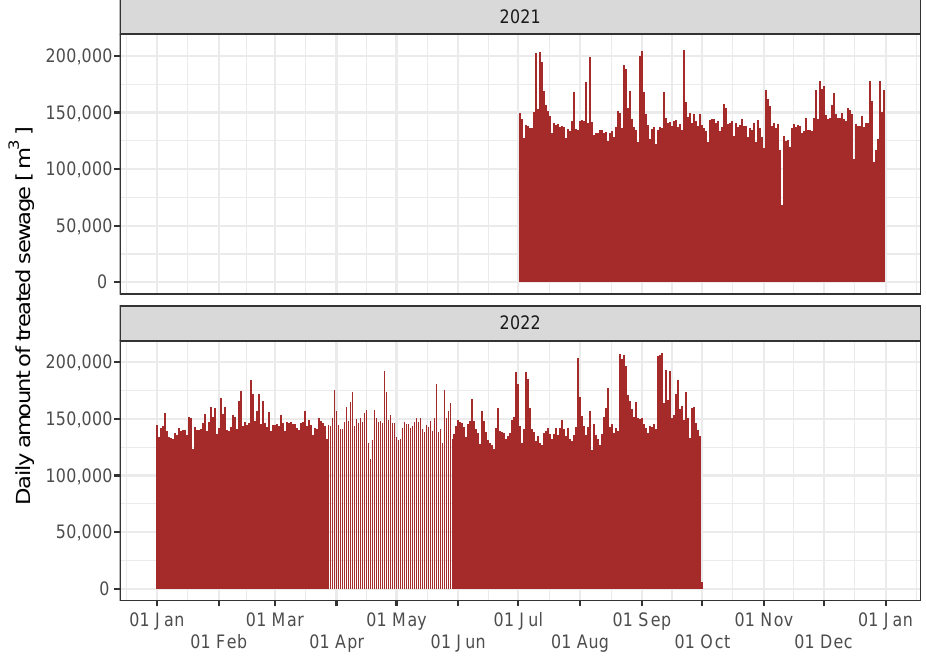
Figure 6. Daily amount of treated wastewater discharged to the